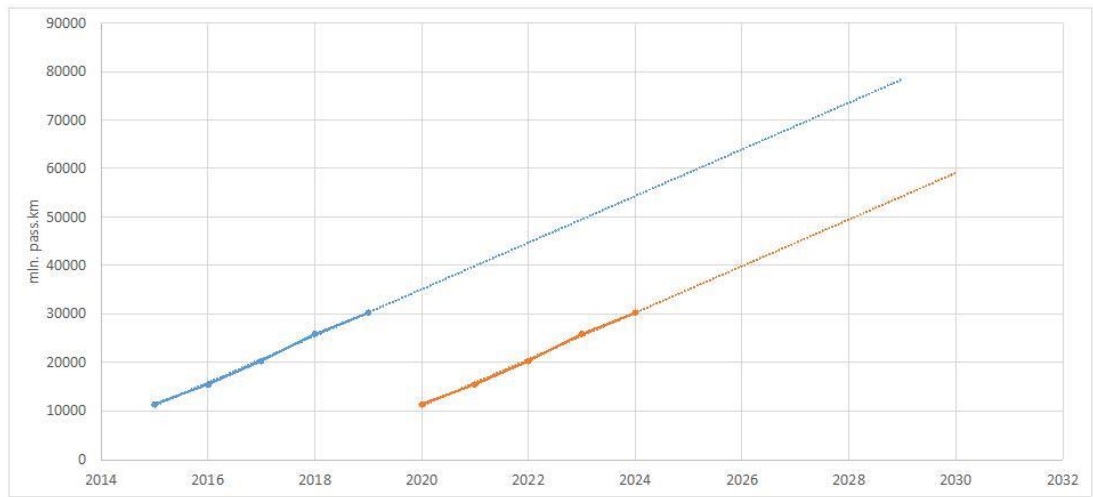
Fig. 3. Forecast for air passenger transportation for